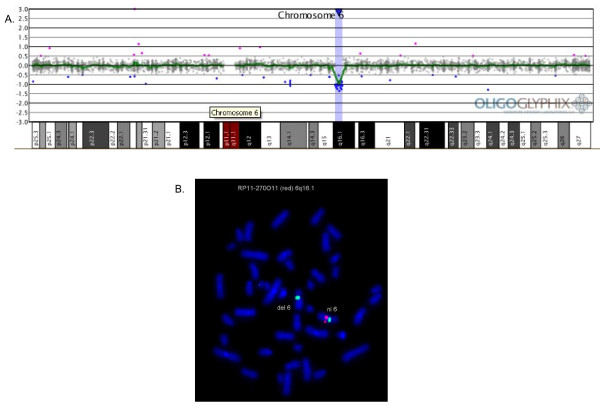
Analysis of deletion encompassing EPHA7 on 6q16.1. (A) Oligonucleotide microarray plot showing a copy-number loss of 30 oligo probes spanning 2.16 Mb at 6q16.1 (chr6:92,836,995–94,905,920). Probes are ordered on the x-axis according to physical mapping positions with distal 6p to the left and distal 6q to the right. (B) FISH demonstrating deletion of EPHA7. BAC clone RP11-270O11 which encompasses EPHA7 was labeled in red and the centromere probe to chromosome 6 (D6Z1) was labeled in green as a control. One red signal was present, indicating deletion of EPHA7.